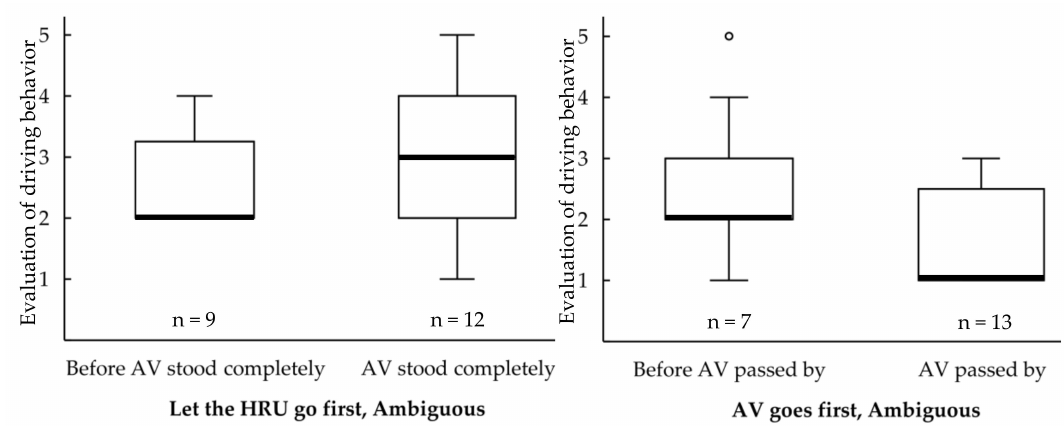
Figure 11. Boxplots for evaluation of driving behavior (1 = very poor, 5 = very good) for the VR setup, segregated by time of decision (before the AV reached standstill or after the AV reached standstill, and before the AV passed by or waited until the AV passed by).[M3] [W4]